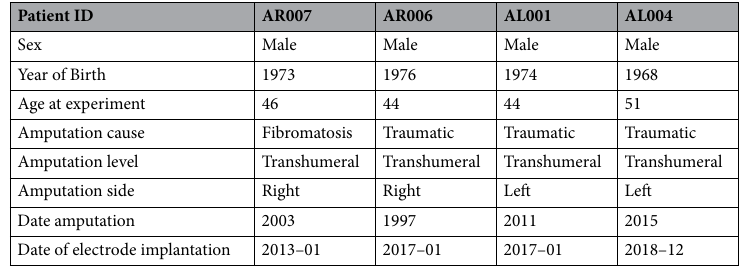
Table 1. Demographic overview of the participants with